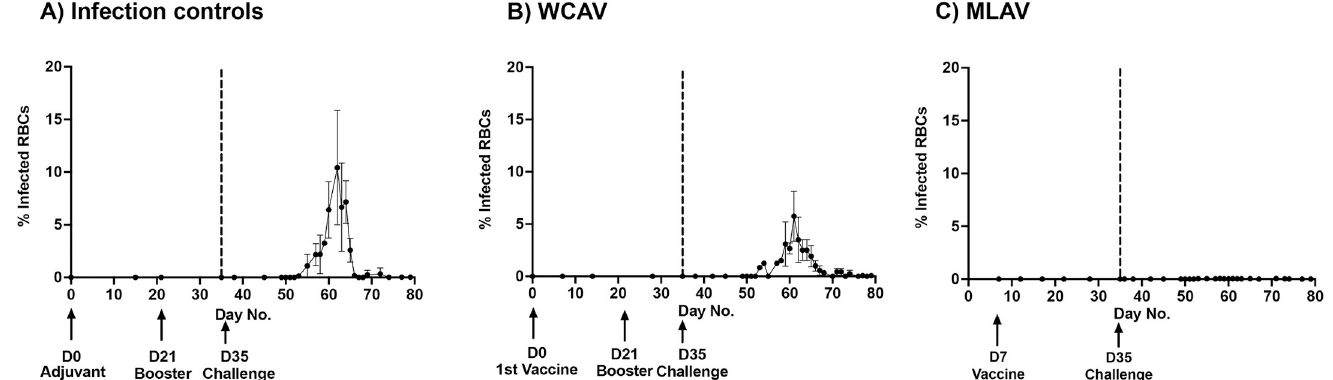
Fig 5. Percent infected erythrocytes as measured by light microscopy. Average percent infected erythrocytes following enumeration in 20 randomly chosen fields under 40x magnification and presented for all groups throughout the study period. Days of vaccinations and infection challenges were as in Fig 3. (significance for days 55–65) At significance level α = 0.05, One-way ANOVA with repeated measures showed that percent infected erythrocytes (bacteremia) were significantly different between the infection control, WCAV and MLAV groups (P = 0.0058 �� ), for several days post-challenge. Additionally, Tukey’s multiple comparisons test showed significant differences between infection control and MLAV (P = 0.0334 � ) groups, as well as between WCAV and MLAV (P = 0.0117 � groups. No significant difference between infection control and WCAV was observed.